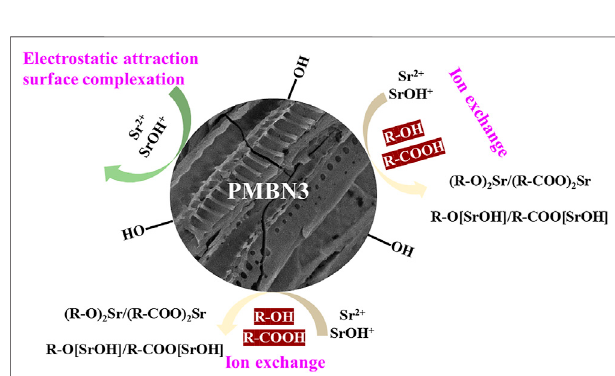
FIGURE 6 | Adsorption mechanism of Sr(II) onto